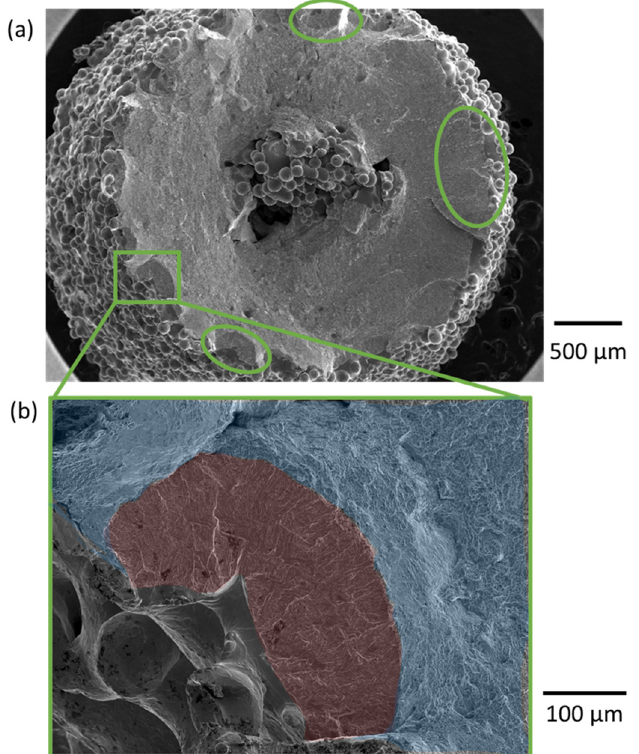
Figure 10. Fractographs of a representative as ‐ built specimen with 3 ‐ mm thickness (low ‐ level). ( a ) Low magnification SEM view. Despite the large pore at the center of the specimen, multiple origins were identified along the surface. ( b ) Higher resolution micrograph indicating fatigue crack initiation from the surface. Red: Stage II fatigue crack propagation zone. Blue: Stage III fast fracture.